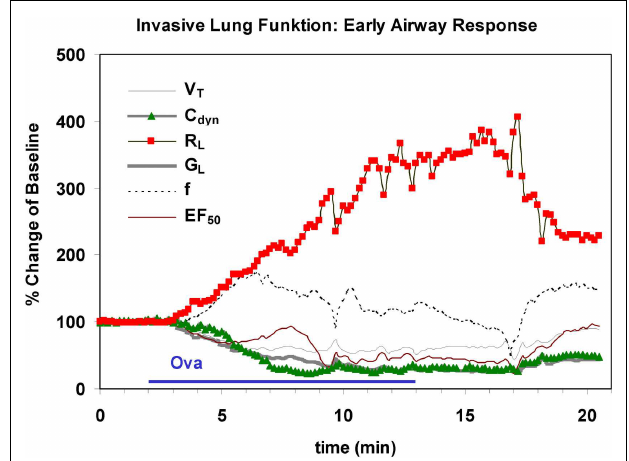
FIGURE 5 | Invasive body plethysmography system. (A) Diagram of a plethysmograph used for pulmonary function testing of anesthetized, orotracheally intubated rodents [shown is a unit for a mouse, reprinted with permission from Glaab et al. (2004)]. A thermostat-controlled water basin (37˚C) is built in the plethysmograph chamber to avoid decrease in body